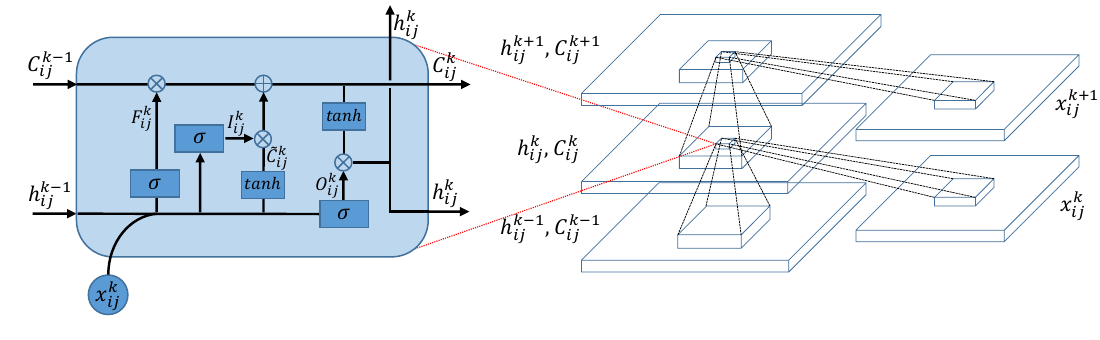
Figure 3. The structure of